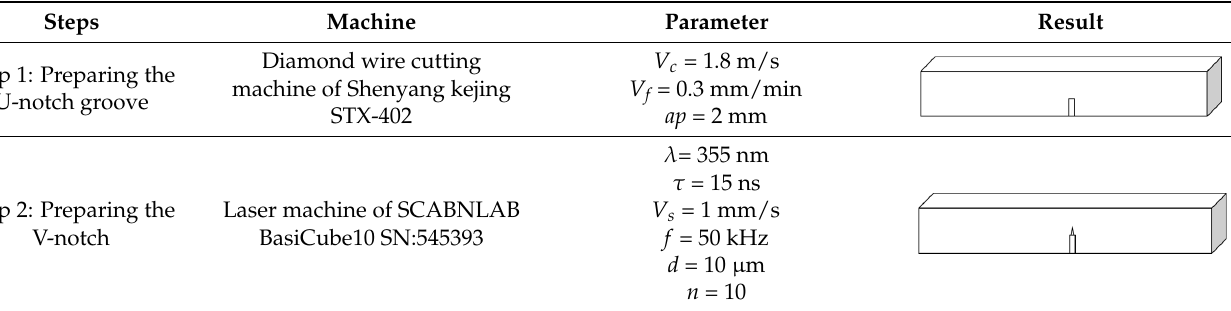
Table 2. Preparing the standard sample.